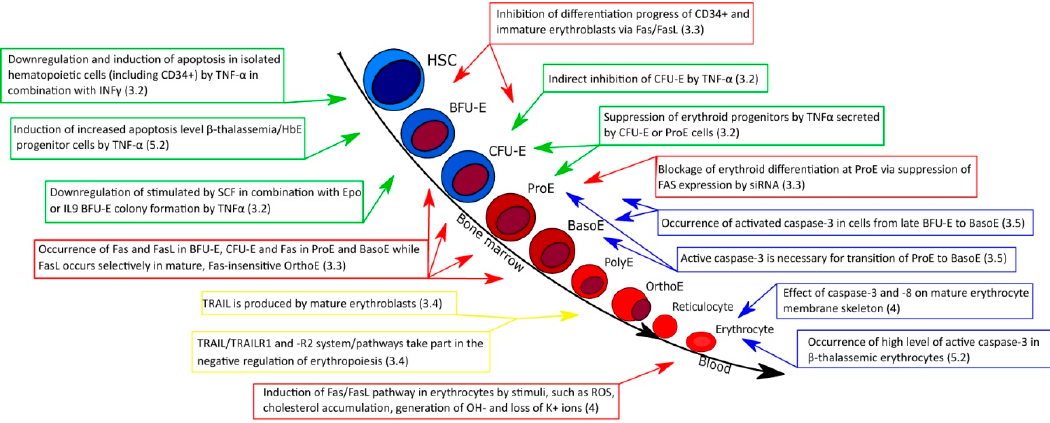
Figure 4. Erythropoiesis and chosen regulatory events connected with apoptotic signals and effectors mentioned in the text. Color code: green: TNF α -, red: Fas/tumor necrosis factor ligand superfamily member 6 (FasL), yellow TRAIL/TNF-related apoptosis-inducing ligand receptor (TRAILR)-, and blue caspase-3/-8- related events.